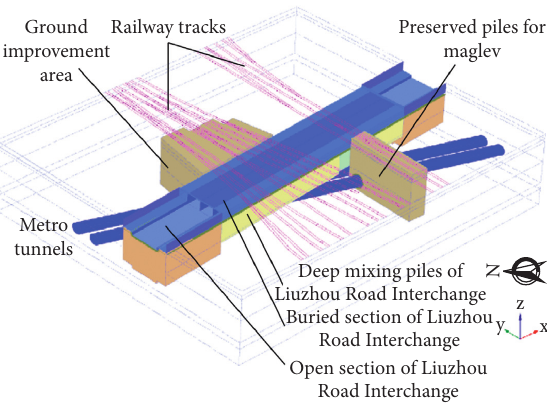
Figure 5: Proposed 3D finite element model